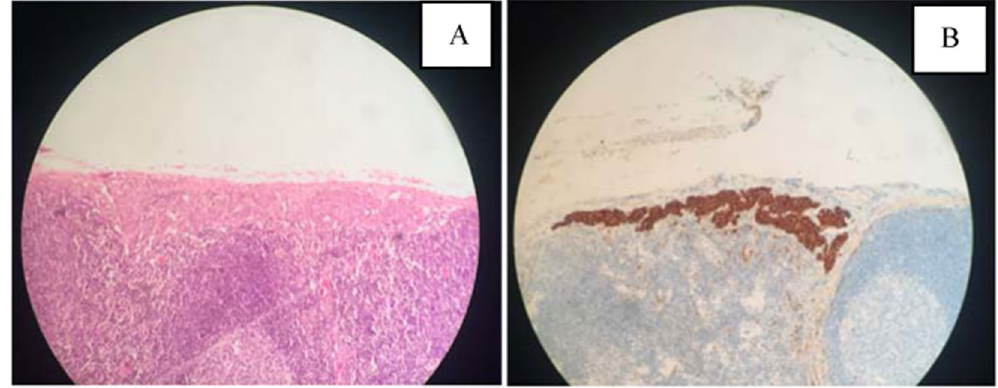
Figure 2. ( A ) Microscopic image of lymph node micrometastasis by Hematoxylin/Eosin. ( B ) Microscopic image of lymph node micrometastatis by Immunohistochemistry(AE1/AE3).